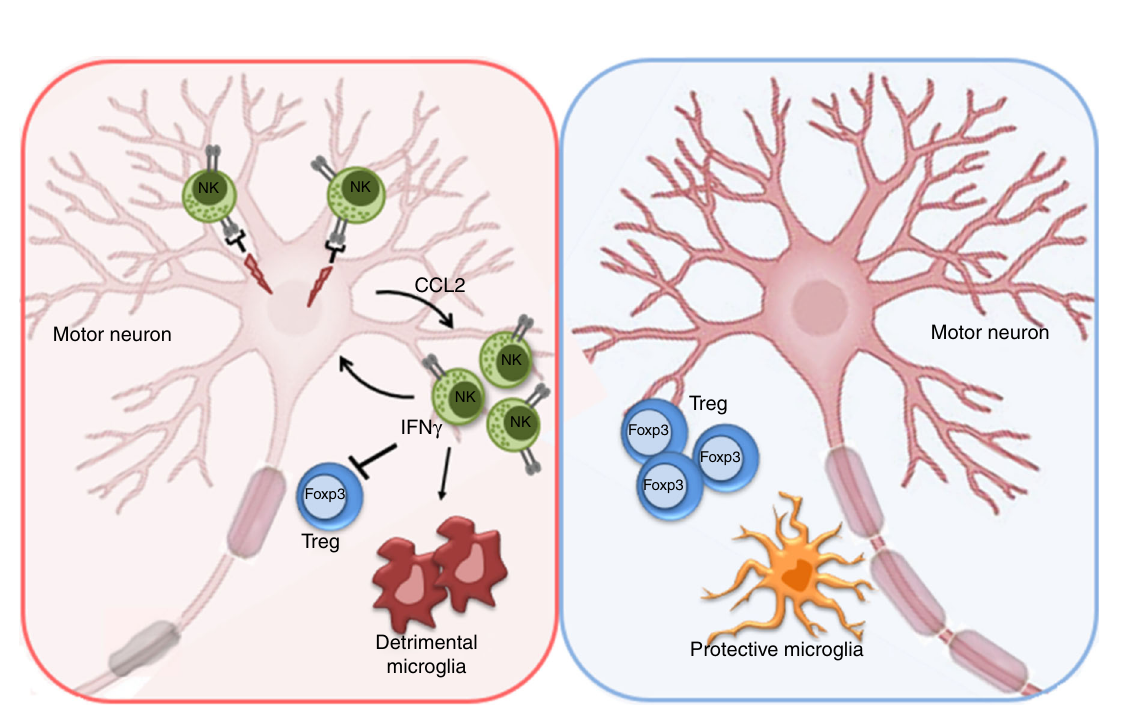
Fig. 8 Graphic summary. (Left) NK cells ’ effects in the spinal cord of hSOD1 G93A mice at the early symptomatic stage. NK cells directly exert cytotoxic activity against MNs through the NKG2D-Mult-1 axis. Furthermore, IFN γ released by NK cells: (i) increases the release of CCL2 by damaged neurons; (ii) reduces the number of Treg Foxp3 + cells; (iii) shapes microglia toward a pro-in fl ammatory phenotype. (Right) NK cell depletion, in hSOD1 G93A mice, induces neuroprotective microglia phenotype, increases the number of Treg Foxp3 + cells, protecting the